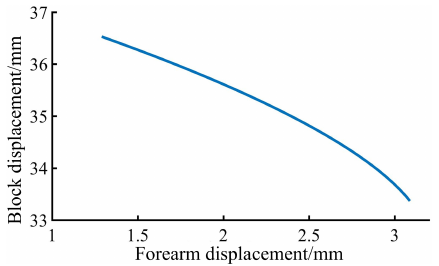
Figure 10. Change of stop displacement of winding robot during pushing